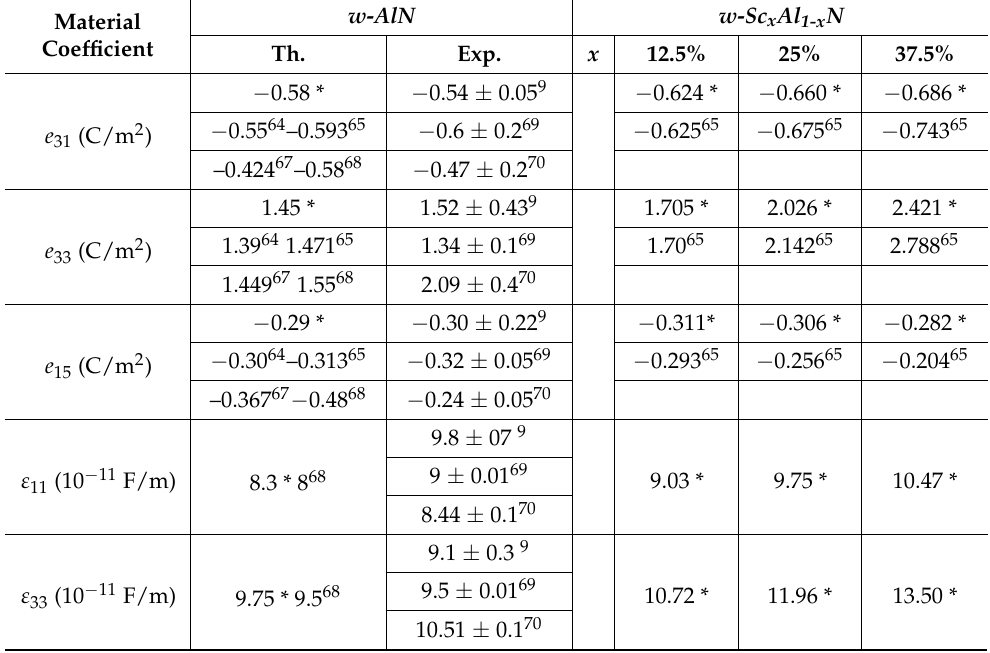
Table 2. Comparison of calculated piezoelectric ( e 15 , e 31 , e 33 ) and dielectric constants ( ε 11 , ε 33 ) for w-Sc x Al 1-x N compound between our results (*) and the